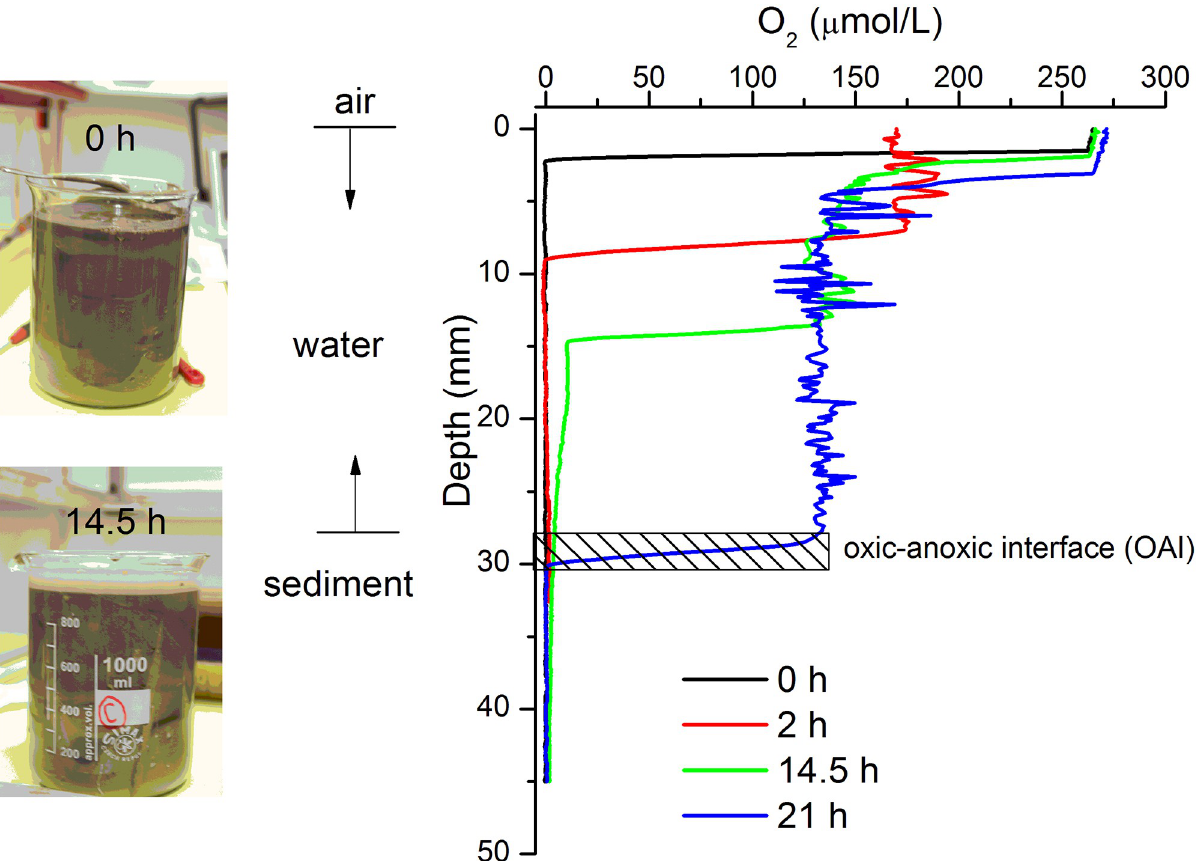
Fig 3. Reformation of oxygen gradient in a disturbed sediment. The sediment in a glass baker was stirred completely to form sediment slurry (1000 ml, left top). Let the sediment stabilize until a clear water-sediment interface was reached (e.g. at 14.5 hours) meanwhile oxygen profile was measured continuously from the beginning (0 hour) to reformation of stable oxygen gradient (21 hours). The contour indicated the oxic-anoxic interface which was generally stabilized in the following experiments.